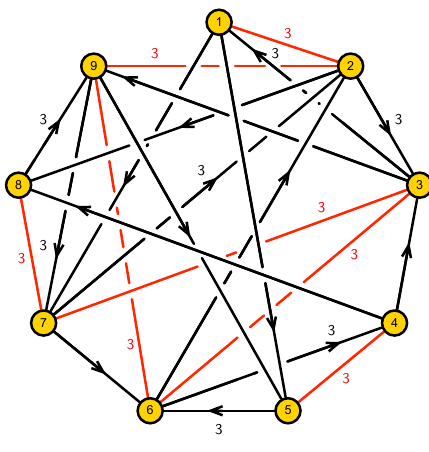
Figure 16 . Quiver for Y 3 , 2 ( CP 2 )